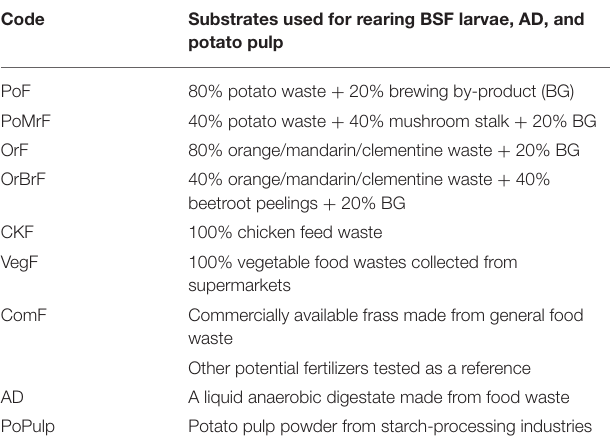
TABLE 1 | Description of the bio-based fertilizers tested under lab conditions.